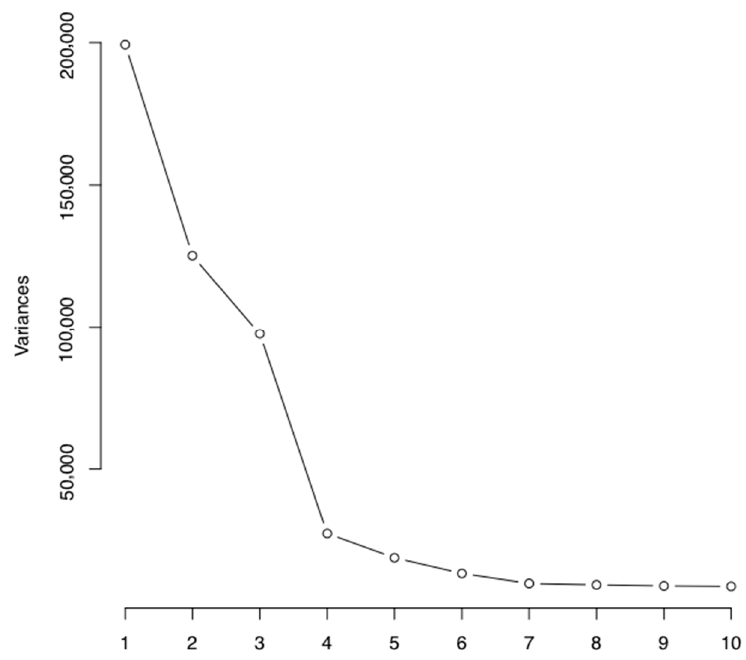
Figure 1. Principal component analysis plot of first 10 principal components responsible for variation in methylation in the ROLO cohort (Randomised controlled trial of a LOw glycaemic index diet in pregnancy).